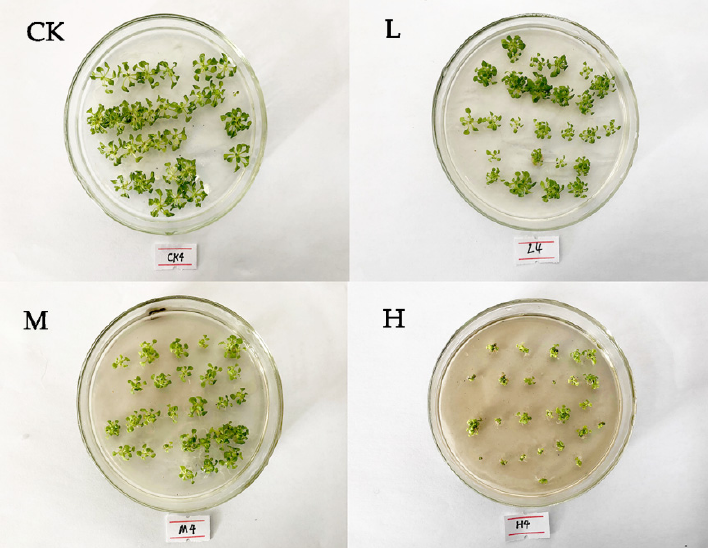
Figure 1. Growth status of 27-day Arabidopsis thaliana treated with Eupatorium adenophorum aqueous extracts in Petri dishes. Abbreviations: CK—control; L—treated by aqueous extract in low concen- extract in high concentration.